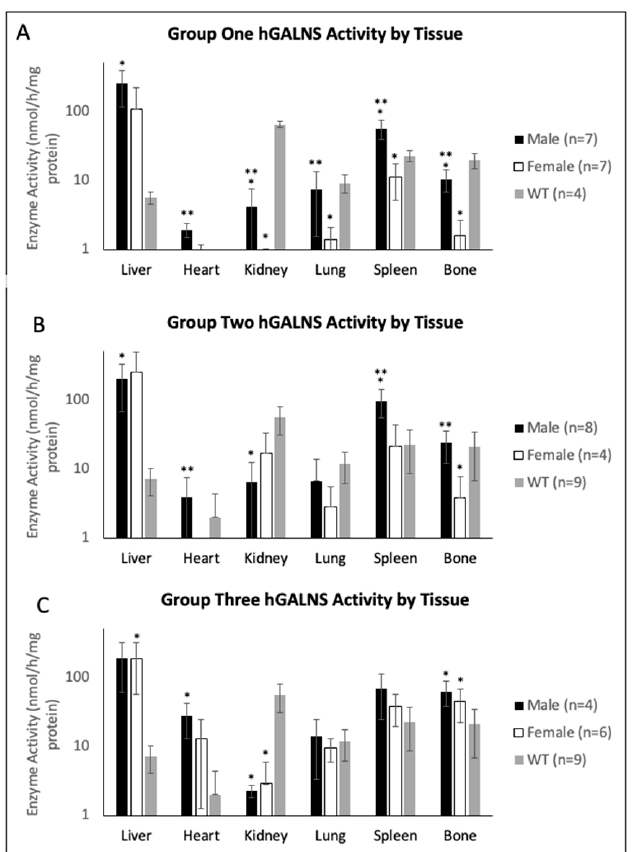
Figure 5. hGALNS activity in tissues for ( A ) Group One (mice treated with the TBG promoter; 5 × 10 13 GC/kg body weight), ( B ) Group Two (mice treated with the CAG promoter; 5 × 10 13 GC/kg body weight), and ( C ) Group Three (mice treated with the TBG promoter; 2 × 10 14 GC/kg body weight). Error bars display standard deviation. * indicates a two-tailed t -test p -value of <0.05 compared to the WT cohort. ** indicates a two-tailed t -test p -value of <0.05 compared to the opposite sex. Graphs are plotted on a logarithmic scale to better display distributions. hGALNS: human N-acetylgalactosamine-6-sulfate sulfatase, TBG: thyroxine-binding globulin, CAG: a ubiquitous promoter including a cytomegalovirus enhancer element, a chicken β -actin promoter, and an intron. In Group One, tissue KS concentrations were measured in the liver and lung, while concentrations were only measured in the liver for Groups Two and Three. In Group One, female mice had higher KS levels than male mice in both lung and liver (Figure 6A). AAV gene transfer reduced the KS concentration in the liver of both males and females but were still higher than normal levels, whereas the lung KS levels were normalized in males. In Groups Two and Three, treated with the same doses, liver KS levels were not different between male and female mice (Figure